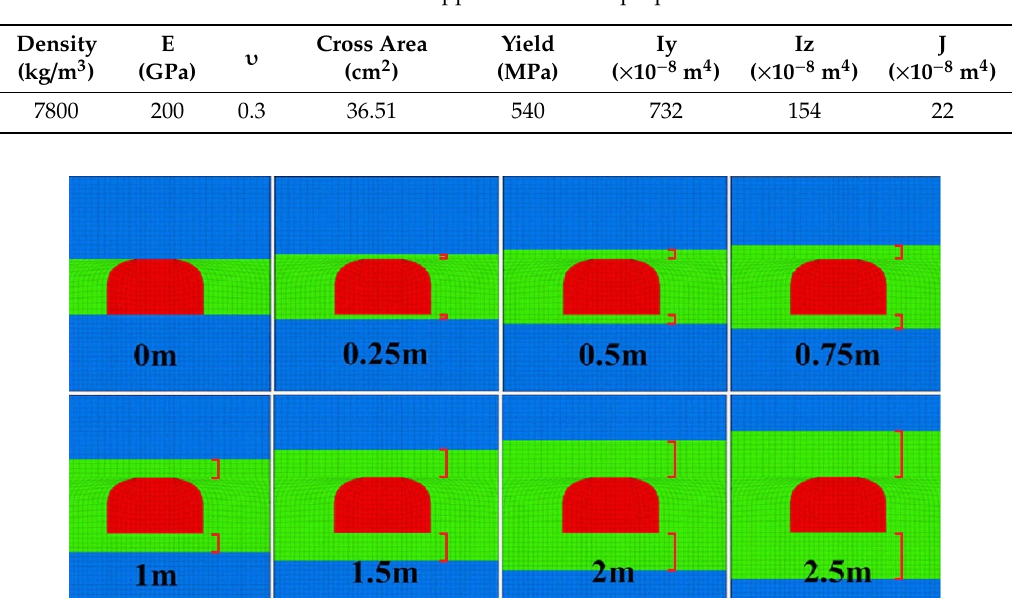
Table 2. Roof support mechanical properties.